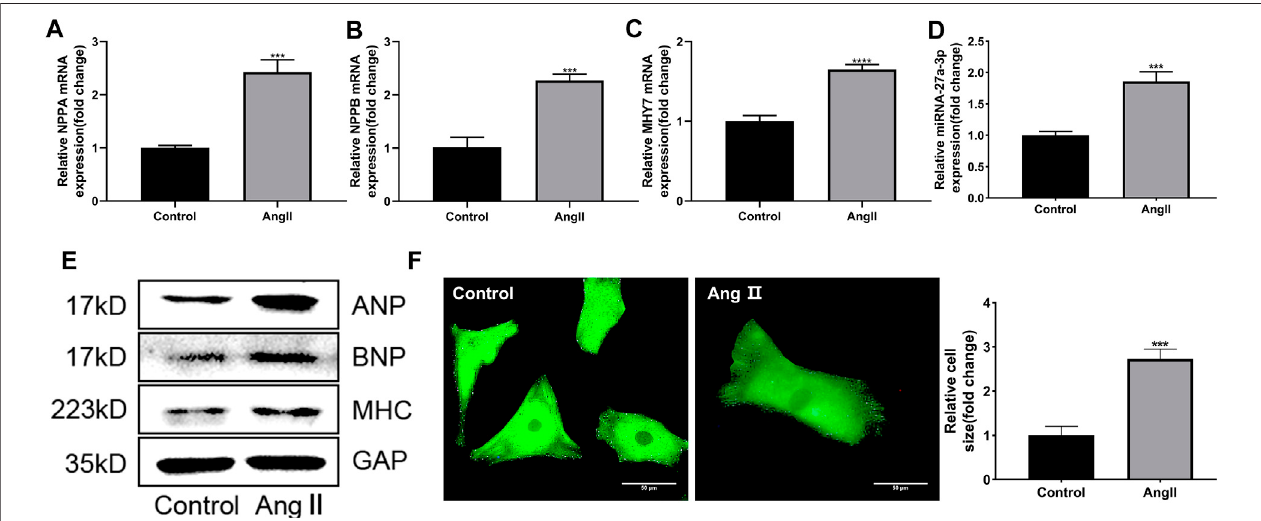
FIGURE 1 | Ang II induced cardiac hypertrophy in neonatal rat cardiomyocytes. (A – C) The expressions of cardiac hypertrophy related genes NPPA , NPPB and MHY7 were increased after Ang II treatment. (D) The expression of miR-27a-3p increased after Ang II treatment. (E) The protein expressions of cardiac hypertrophy related genes ANP, BNP and β -MHC were increased after Ang II treatment. (F) Morphological changes after Ang II treatment in neonatal rat cardiomyocytes. Scale bar, 50 μ m. All the values are the mean of three independent experiments ( n (cid:2) 3). **** p < 0.0001, *** p < 0.001 vs.